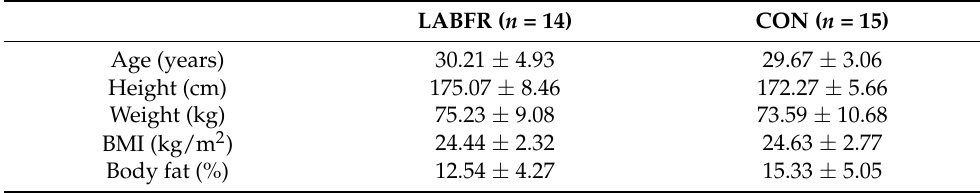
Table 1. Physical characteristics of the